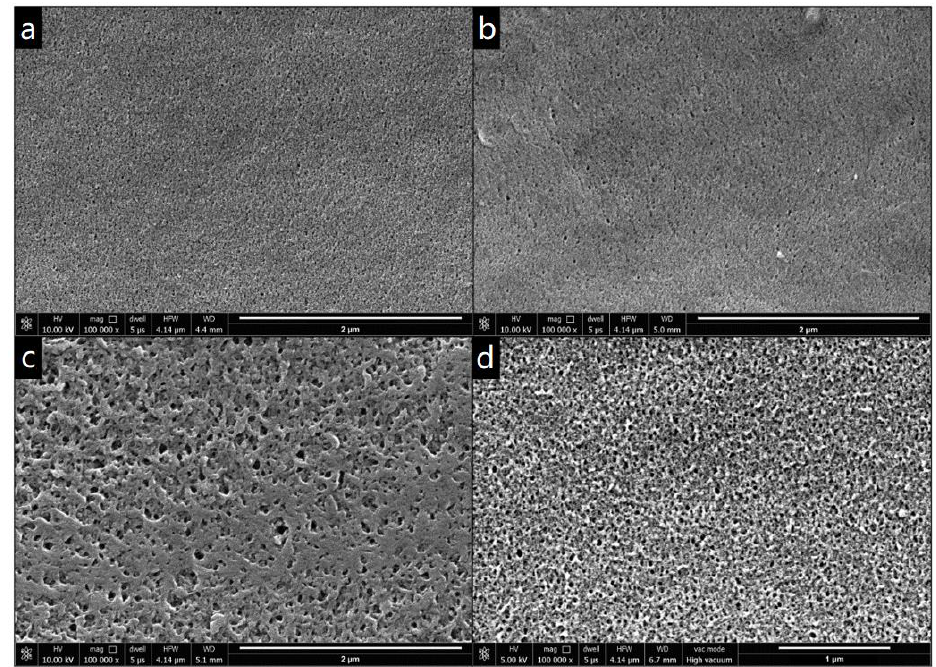
Figure 4. Scanning electron microscopy (SEM) images of membrane surface of ( A ) GO-0 wt%, ( B ) GO S -0.2 wt%, ( C ) GO H -0.2 wt% and ( D ) GO T -0.1 wt% membrane. Scale bars are 2 μm for images A, B and C; and 1 μm for image D.